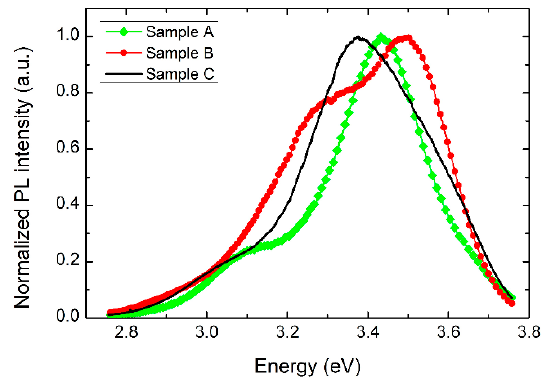
Figure 6. Normalized PL intensity spectrum from the three synthesized samples with controlled composition.